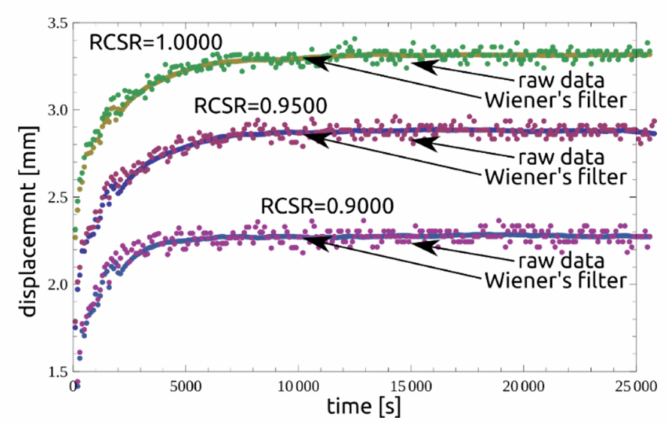
Figure 7. Wiener’s filter based on raw data for RCSR = {0.9000, 0.9500,